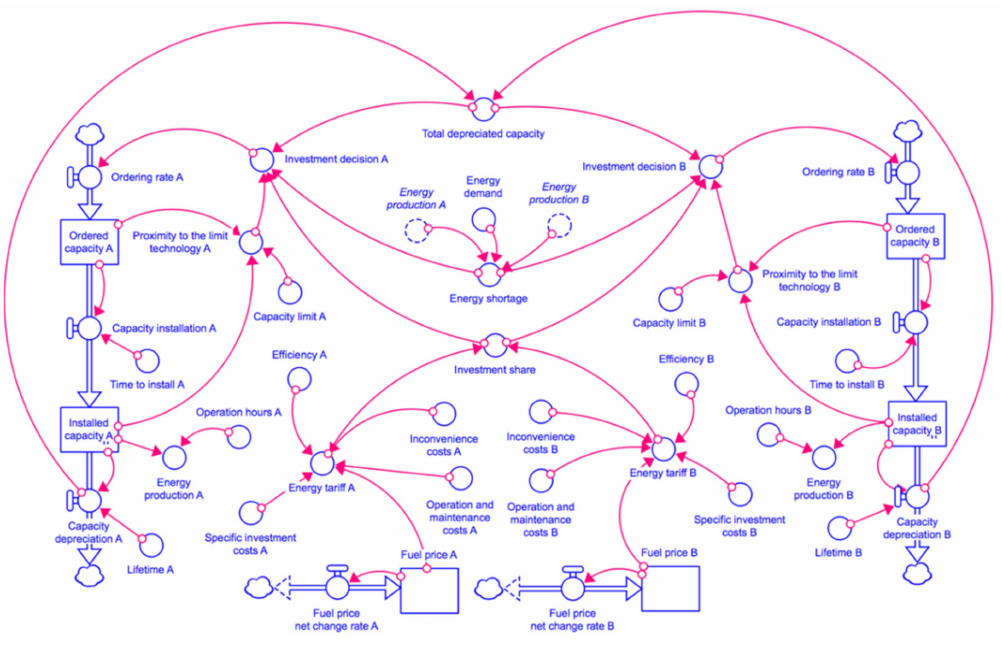
Figure 3. Generic stock-and-flow structure for energy supply sector.